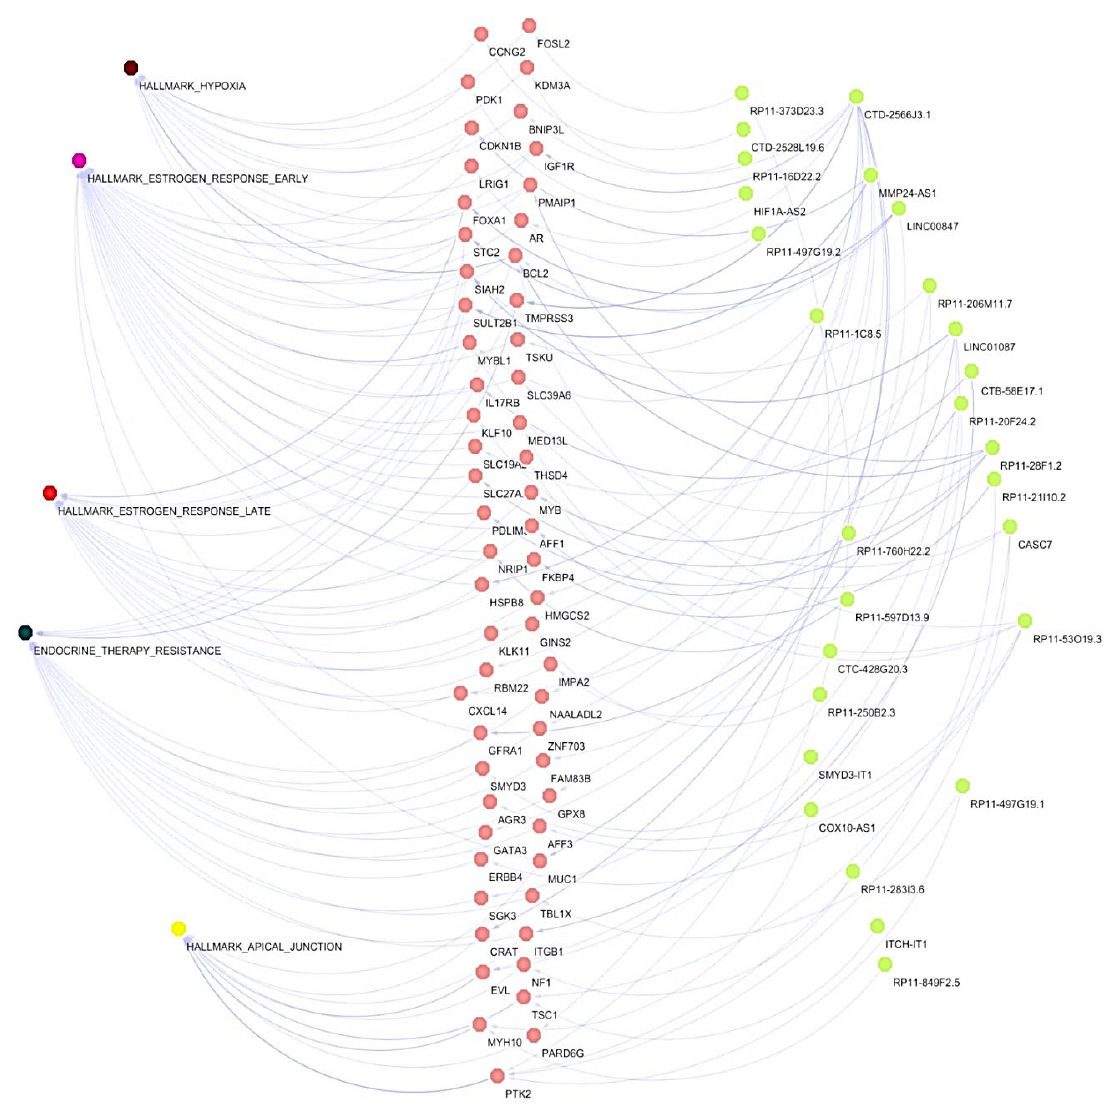
Figure 5. Co-expression lncRNAs/mRNAs networks common in BT-474 cell grown in 3D cultures and breast tumors (TCGA). The diagram shows how the cellular processes associated to cancer hallmarks, could be regulated by ncRNAs/mRNAs pairs that are common in BT-474 cultures and breast biopsies. Blue dot: lncRNAs; green dot: mRNAs; pink dot; multiple colors; cancer hallmarks and therapy resistance.